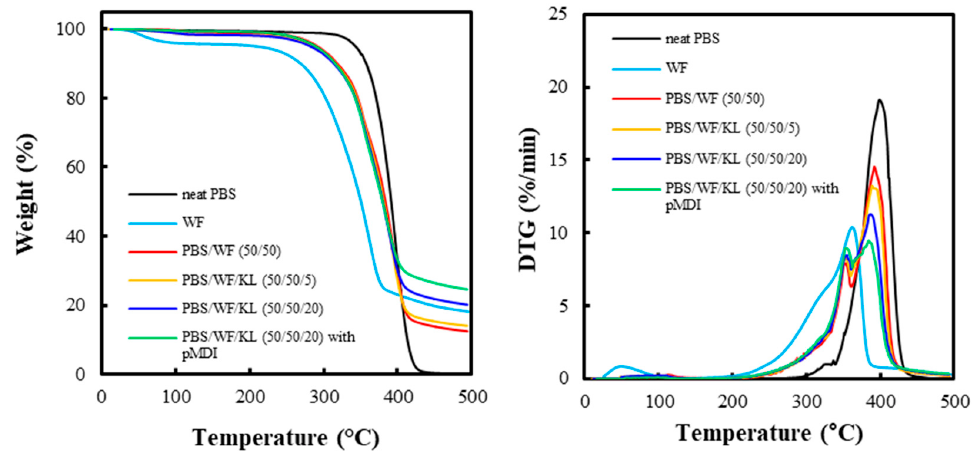
Figure 8. Thermogravimetric analysis (TGA) and derivative thermogravimetry (DTG) curves for the PBS/WF and PBS/WF/KL composites with and without pMDI.